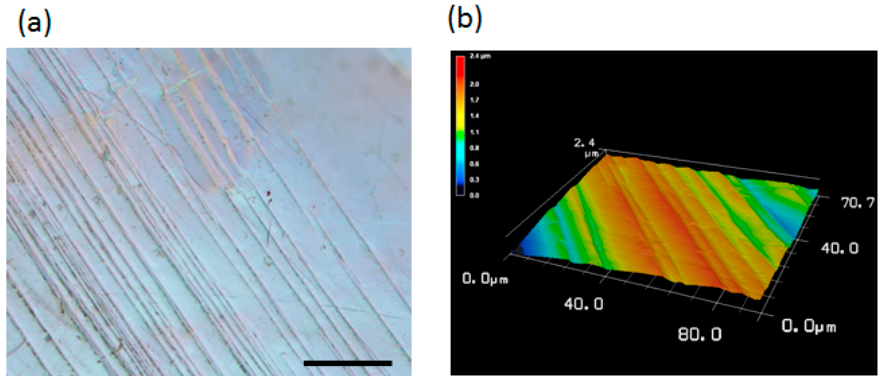
Figure 1. ( a ) Optical microscope and ( b ) laser microscope image of the surface of the obtained specimens. Scale bar: 100 μ m.